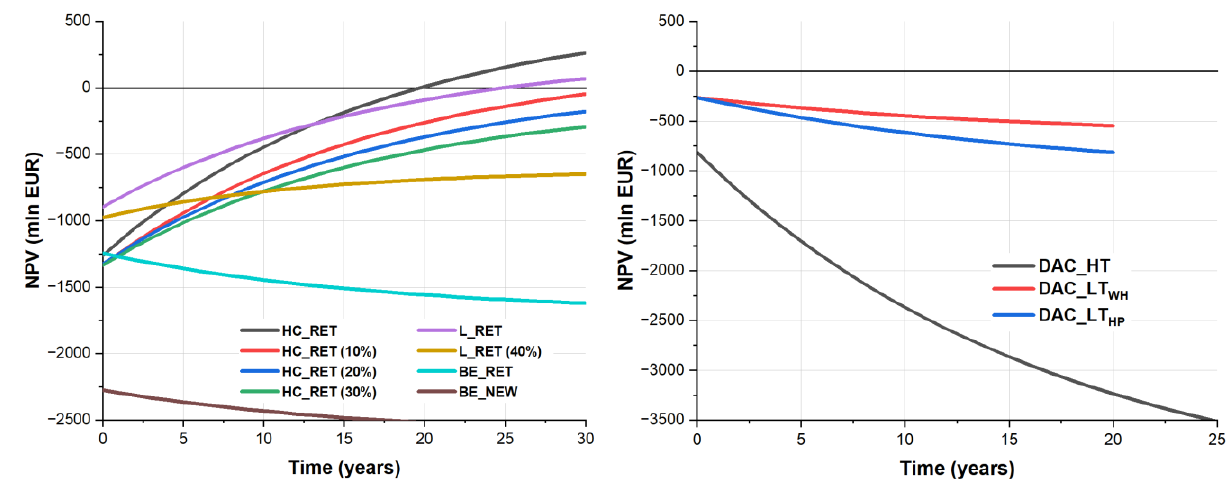
Figure 7. The Net Present Values (NPV) for analyzed units.